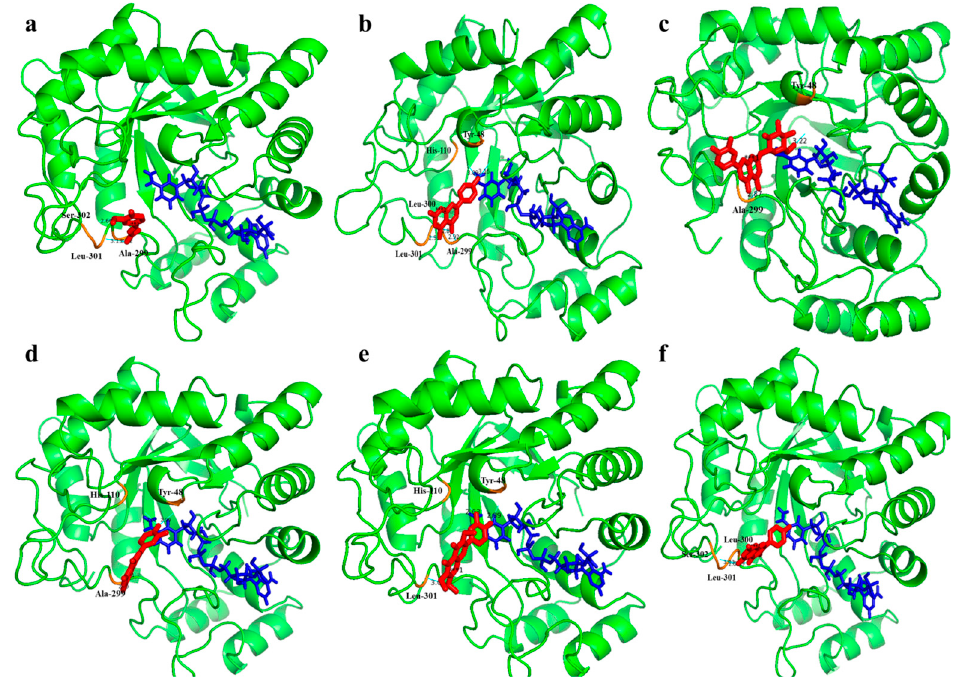
Figure 4. Docking models of ferulic acid ( a ), apigenin ( b ), luteolin-7- O -glucoside ( c ), luteolin ( d ), chrysosplenol ( e ), and kaempferol ( f ). The structure of aldose reductase is in green; the structures of the ligands are in red; the interactions of the residues with the ligands are shown in orange. (For interpretation of the references to color in this figure legend, the reader is referred to the web version of this article).